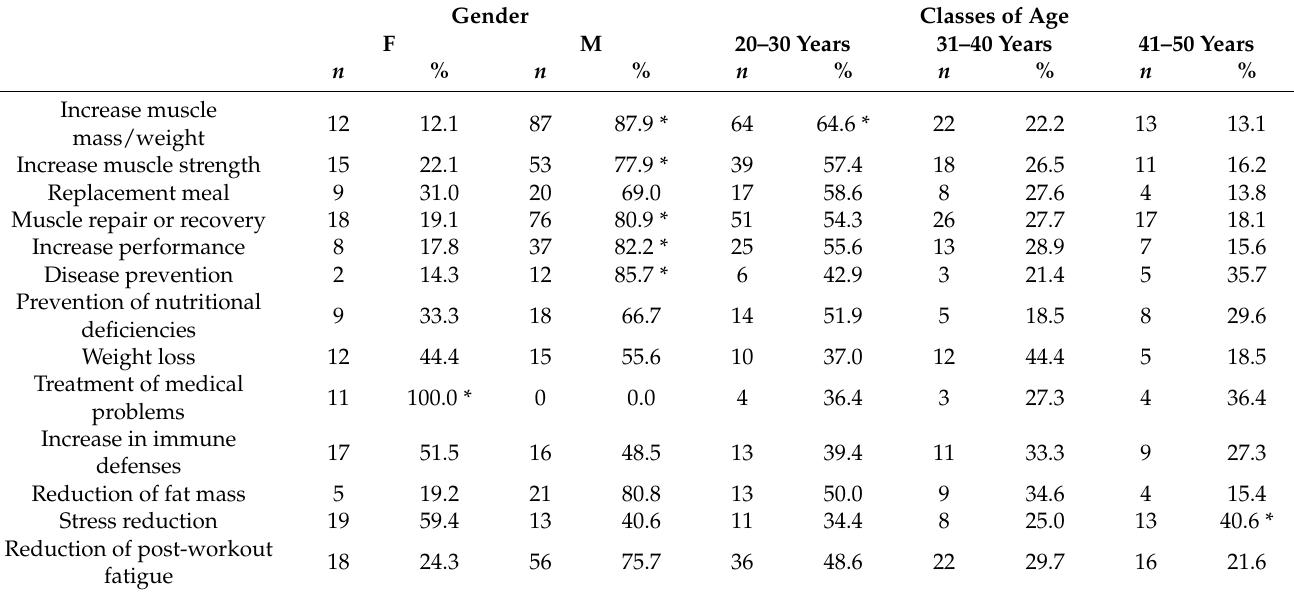
Table 4. Reasons for using sport food supplements by sample characteristics.